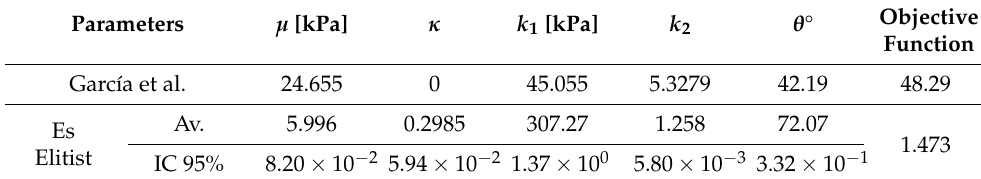
Table 3. Parameters of the fittings obtained from the experimental data of García et al. with evolu- tionary strategies, stabilization criterion and GHO